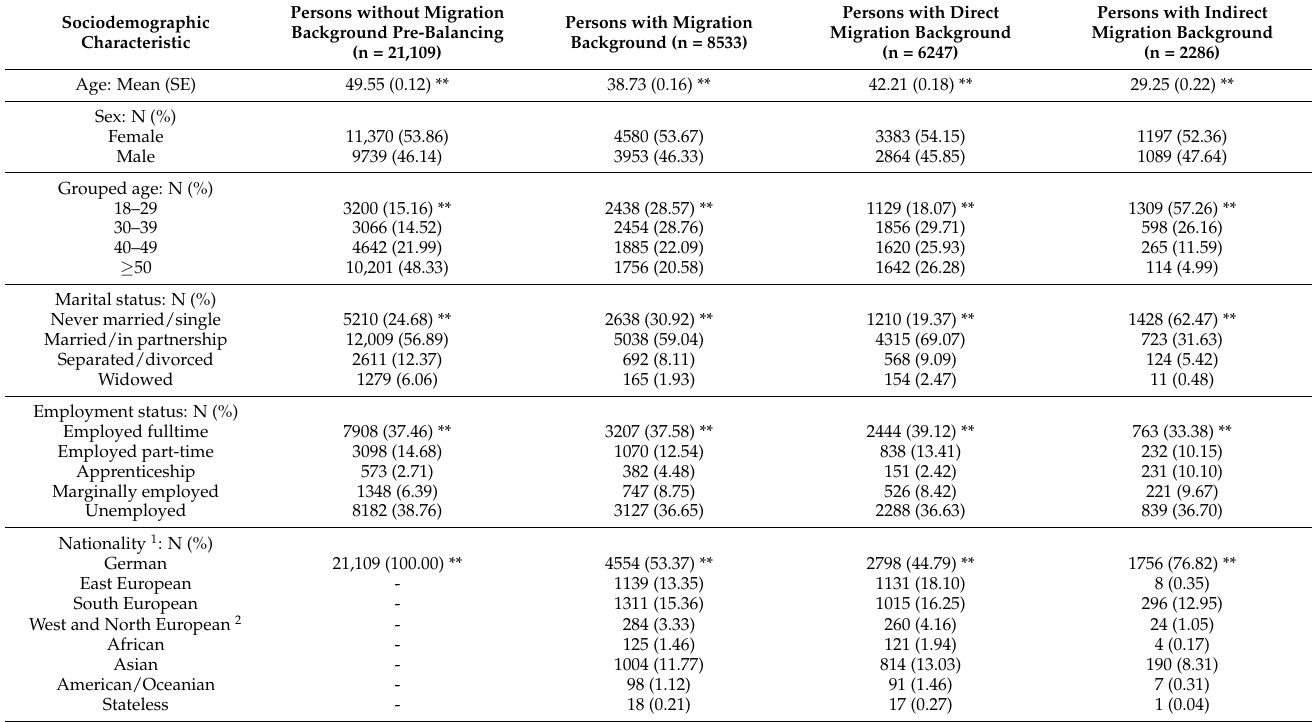
Table 1. Sociodemographic characteristics of the sample, pre-balancing (survey years 2014 and 2016). Sociodemographic